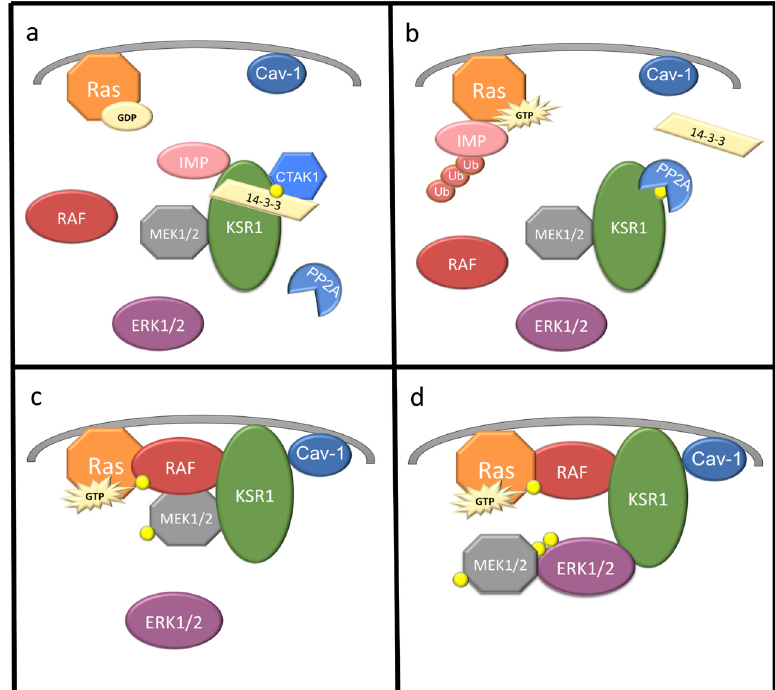
Figure 1. KSR1 dynamically regulates the Raf/MEK/ERK kinase cascade. ( a ) KSR1 is constitutively bound to MEK1/2 and IMP. C-TAK1 phosphorylates (yellow circle) KSR1 at Ser392, allowing for 14-3-3 binding and cytoplasmic localization of KSR1. ( b ) Upon Ras activation and GTP binding, IMP dissociates from KSR1, binds Ras, autoubiquitylates, and is degraded. PP2A dephosphorylates KSR1 at Ser392, destroying the 14-3-3 binding site anchoring KSR1. ( c ) KSR1 and MEK1/2 translocate to the plasma membrane, where KSR1 interacts with Raf and MEK1/2 is phosphorylated and activated. ( d ) MEK1/2 dissociates from KSR1 and ERK1/2 is phosphorylated and associates with KSR1, facilitating signaling. Cav-1, caveolin-1; C-TAK1, Cdc25C-associated kinase 1; ERK, extracellular signal-regulated protein kinase; GTP, guanosine triphosphate; IMP, impedes mitogenic signal propagation; KSR1, Kinase Suppressor of Ras 1; MEK, mitogen-activated protein/ extracellular signal-regulated protein kinase kinase; PP2A, protein phosphatase